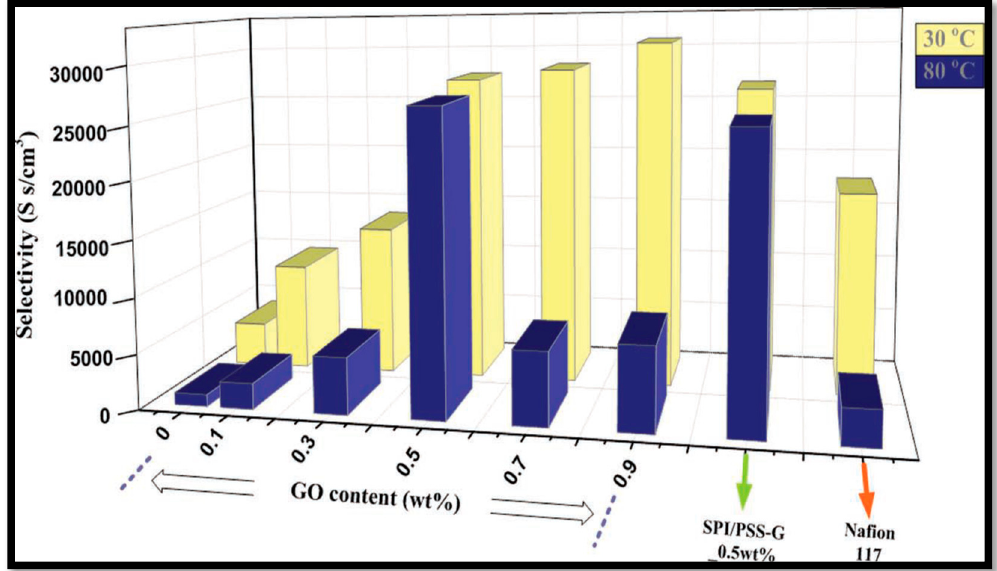
Figure 12. Selectivity of SPI and SPI-PSS-GO composite membranes compared with Nafion-117 membrane. Reproduced from [60], with permission from John Wiley and Sons, 2011.